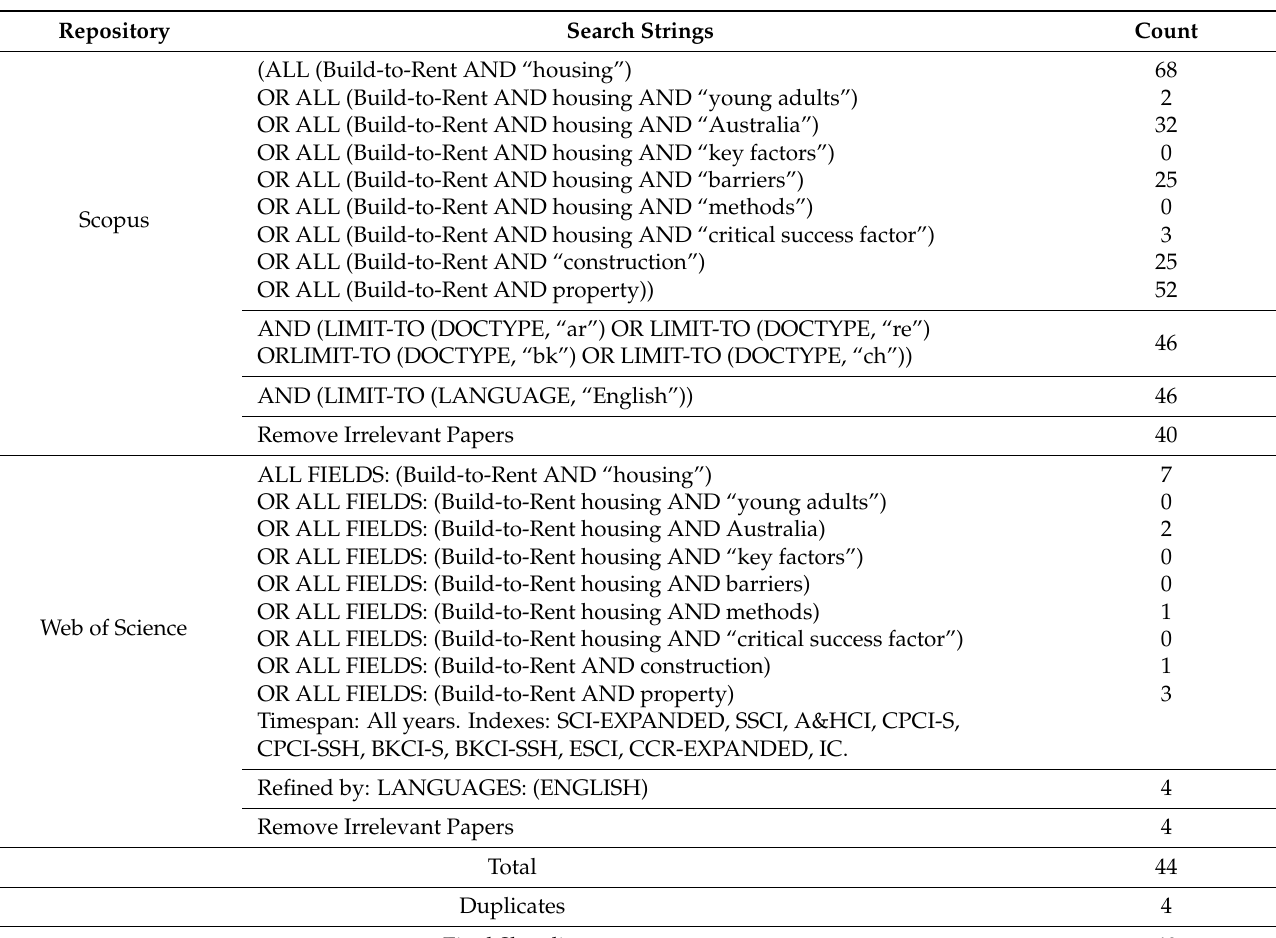
Table 1. Search strings and Keywords for Scopus and Web of